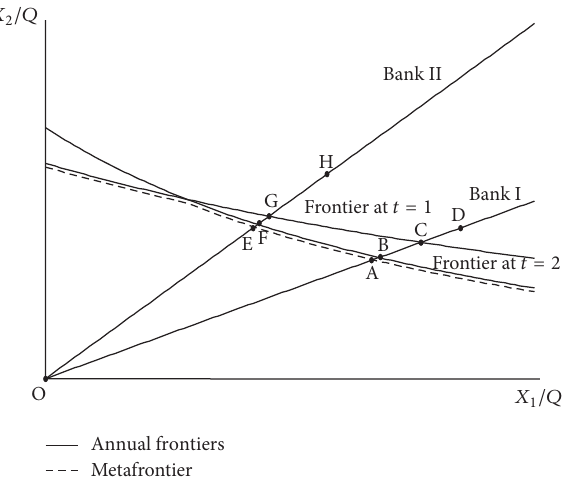
Figure 3: Cost efficiency and technology gap ratio. Table 2: Definitions of